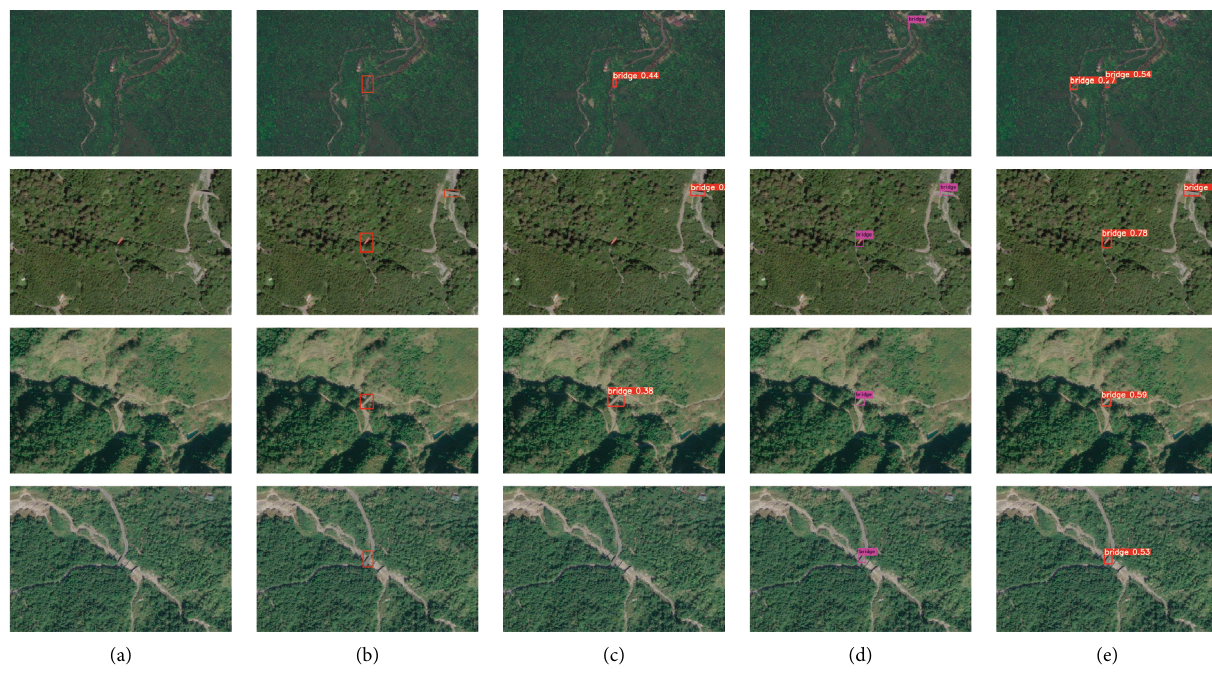
Figure 9: The comparisons of different competing methods for bridge detection under simple backgrounds. From left to right: (a) original images and detected results by (b) Faster R-CNN, (c) YOLOv3, (d) YOLOv4, and (e) YOLOv5s, respectively.